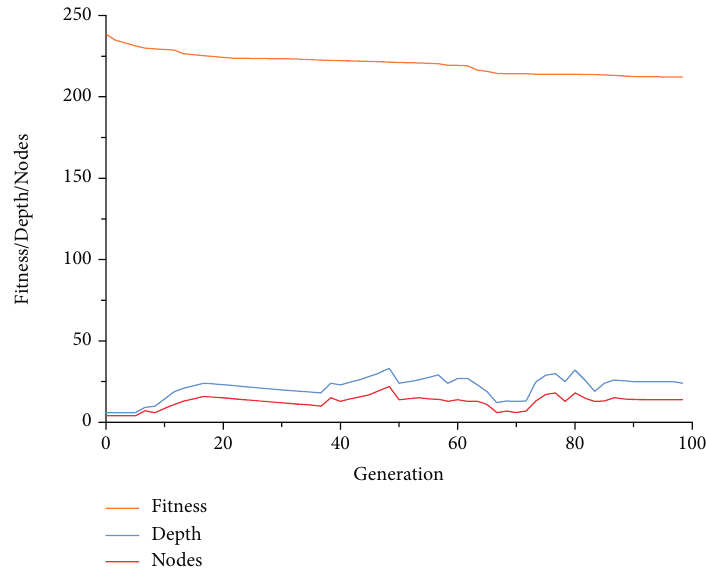
Figure 7: Fitness, depth, and nodes evolution of the optimal individual.